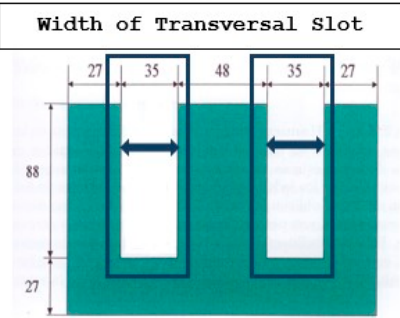
Figure 7. Transversal slots incremented from 10 to 40 mm [16].